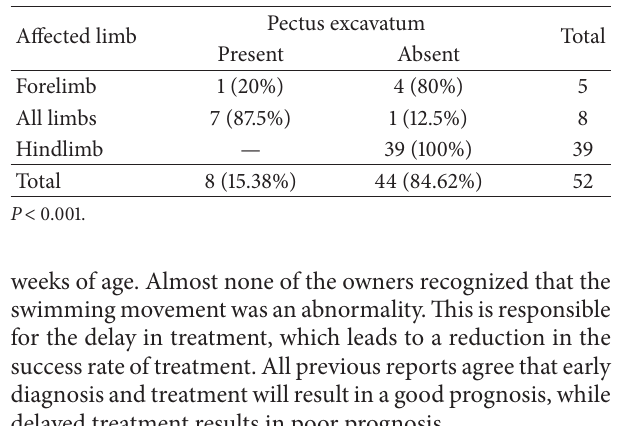
Table 7: Relationship between affected limb and occurrence